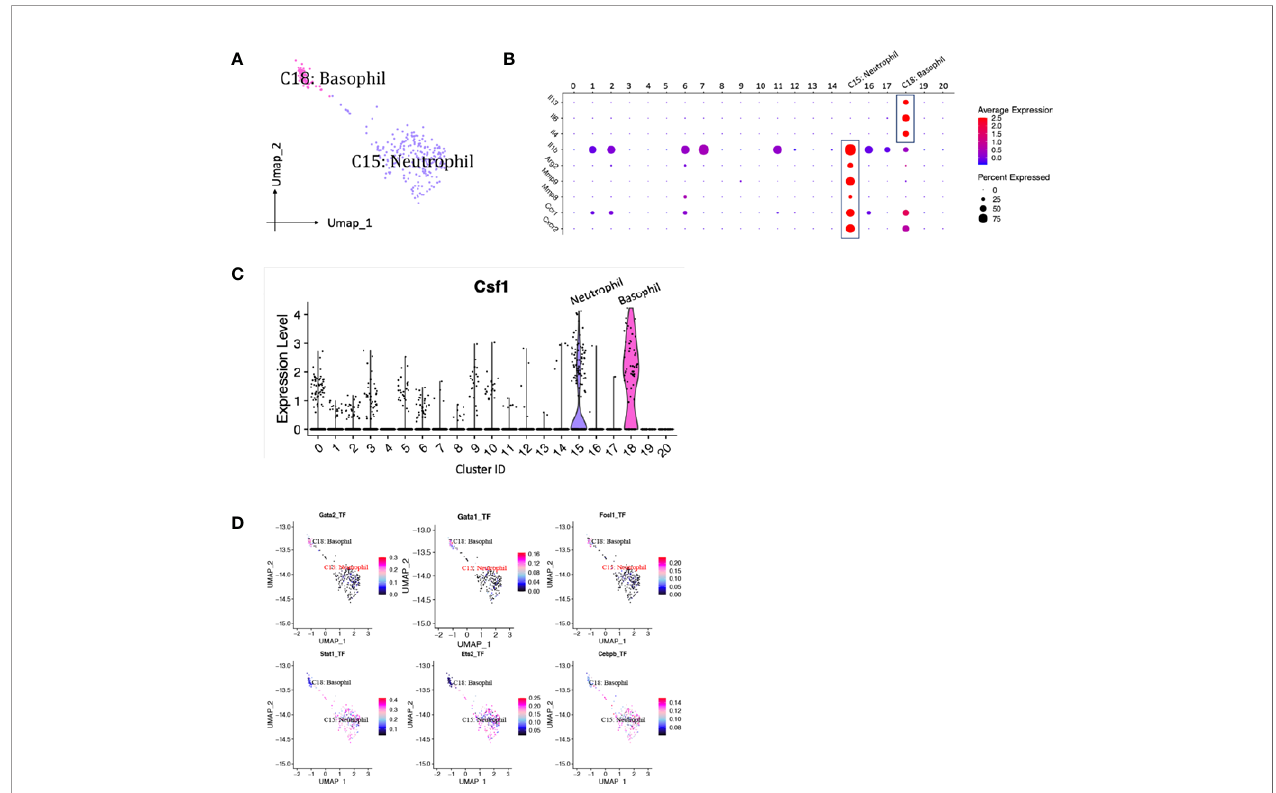
FIGURE 10 | Granulocytes presented in the allografted kidneys. (A) Integrated UMAP projection of one neutrophil cluster (cluster 15) and one basophil cluster (cluster 18) identi fi ed in the kidney grafts, colored according to cluster designation. Cell identities are annotated above the cell dots. (B) Dot plot showing gene expression levels of Il13, Il4, Il6, Il1b, Arg2, Mmp8, Mmp9, Ccr1 and Cxcr2 in all clusters. (C) Violin plot showing normalized expression levels of Csf1 in all clusters. (D) Feature plot showing the AUC scores for the expression of gene sets regulated by transcription factors, as estimated with SCENIC, in neutrophil and basophil cluster. AUC score bar is shown on the right. UMAP, Uniform Manifold Approximation and Projection; AUC, area under the curve; SCENIC, single-cell regulatory network inference and